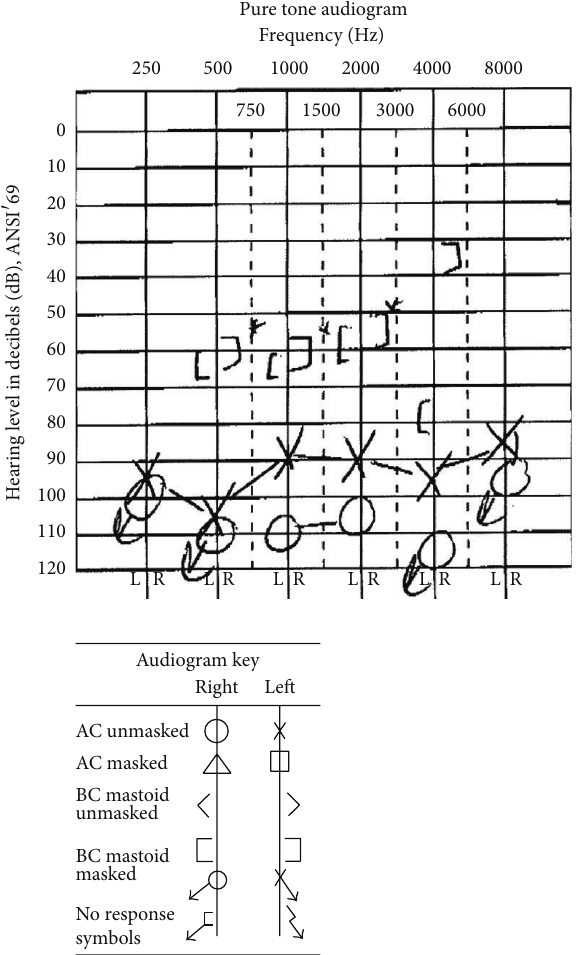
Figure 1: Patient’s pure-tone audiogram, revealing a profound mixed hearing loss bilaterally.